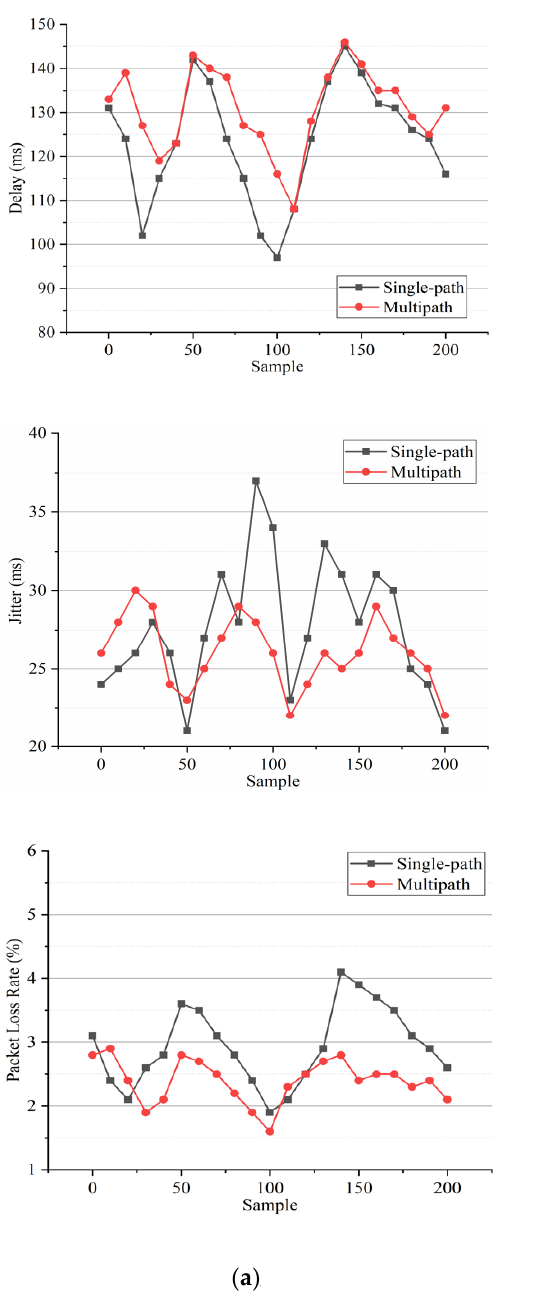
Figure 7. Comparison of sample test results between the single-path transmission and multipath relay transmission. ( a ) is the comparison result of the two transmission methods in the network idle state. ( b ) is the comparison result of the two transmission methods in the network busy state